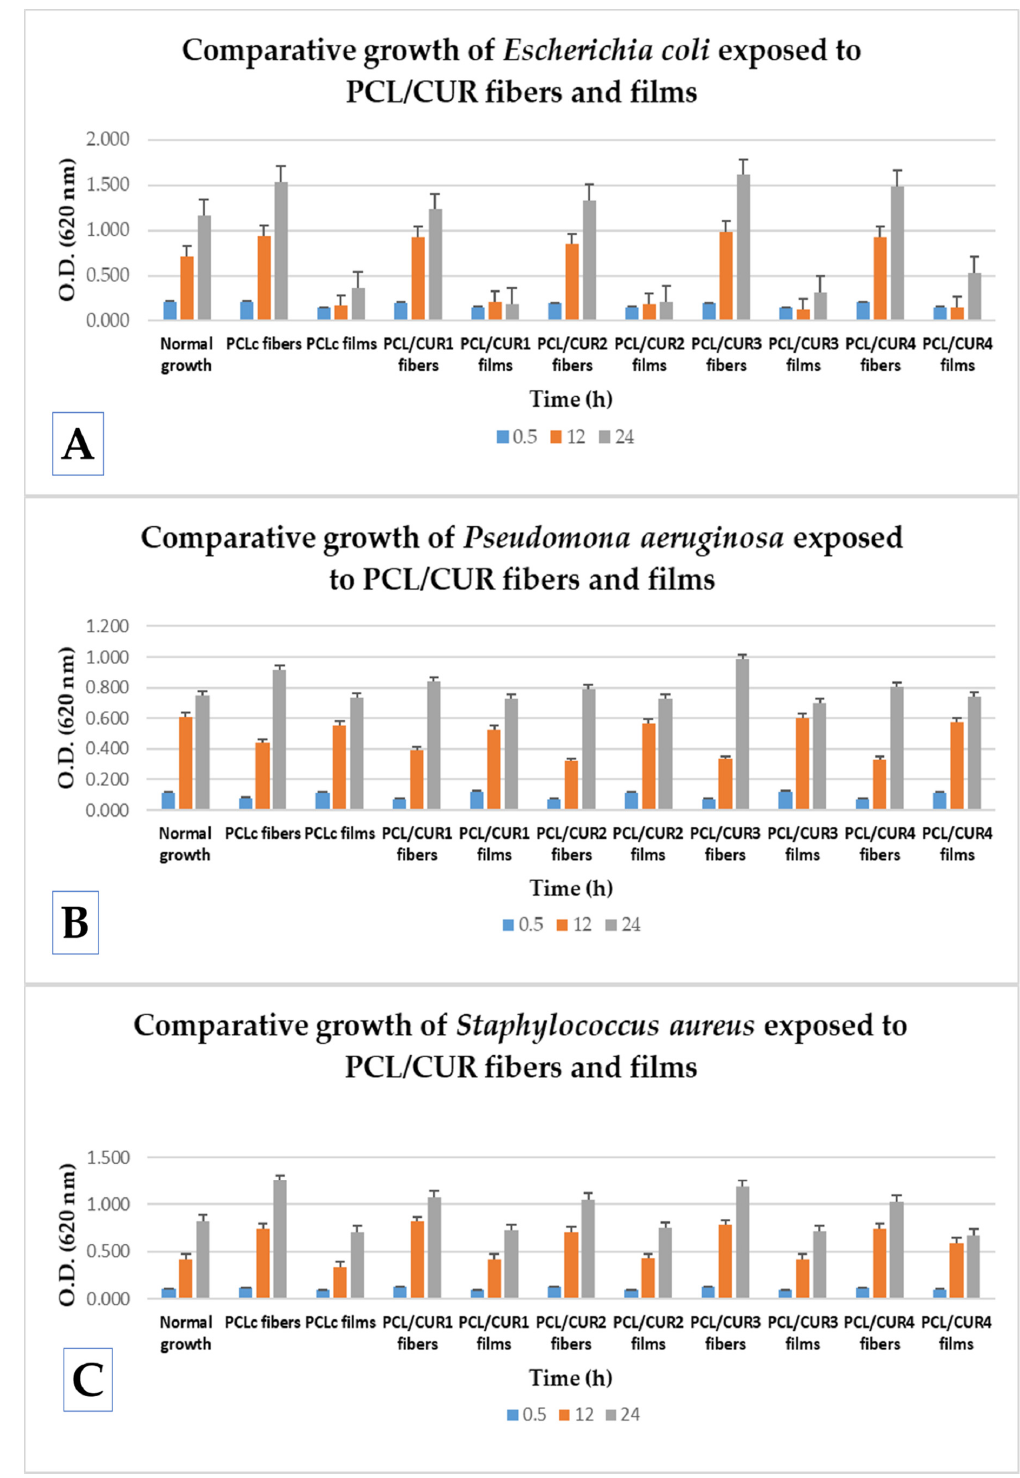
Figure 7. A comparative study of bacterial growth of exposed bacteria to PCL/CUR fibers and PCL/CUR films. ( A ) Escherichia coli ; ( B ) Pseudomona aeruginosa ; ( C ) Staphylococcus aureus . Finally, PCL / CUR fibers e ffi ciently promoted the growth of Staphylococcus aureus compared to PCL / CUR films. At 0.5 h, PCL / CUR fibers promoted ~16% the proliferation rate, and PCL / CUR